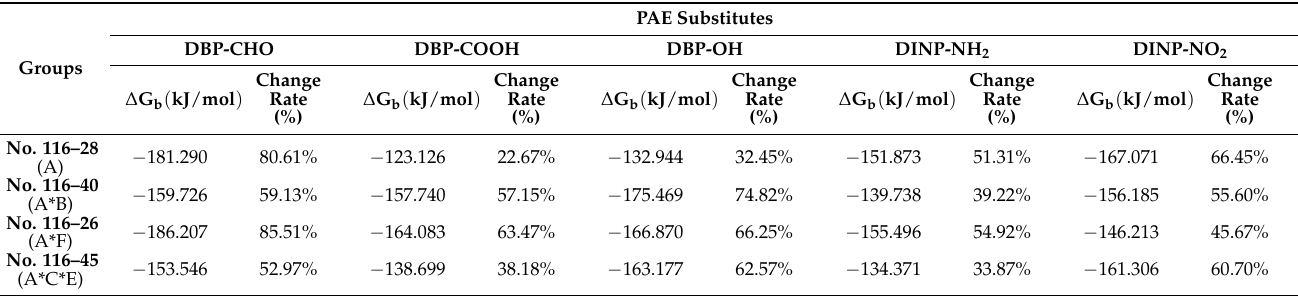
Table 8. The binding free energy of polystyrene 5 polymers with 7CC4 degrading protein after substituting PAE derivatives for A